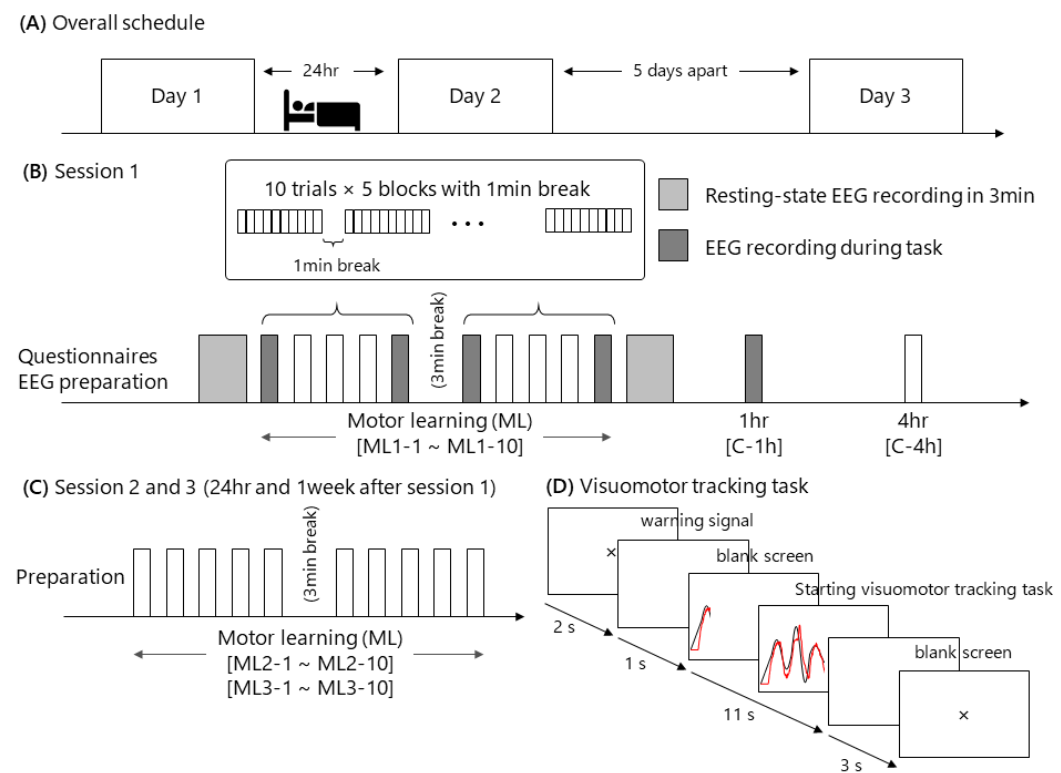
Figure 2. Experimental procedure for motor learning (ML) and overlearning. ( A ) shows the overall schedule of the present experiment. Each participant performed the initial ML on the appointed day (Session 1), followed by overlearning at 24 h (Session 2) and 1 week (Session 3) after the completion of the initial ML. ( B ) presents the experimental procedure during Session 1. After arriving at the laboratory, the participants answered questionnaires about their characteristics, premenstrual syndrome (PMS) and interoceptive awareness, followed by preparation for electroencephalography (EEG) measurements. Next, baseline EEG was recorded in the resting state. Subsequently, the initial ML task, consisting of two sets of 5 blocks with 10 visuomotor tracking task trials in each block (termed ML1-1 to ML1-10), was conducted; EEG recordings were taken during the first, fifth, sixth and tenth blocks (ML1-1, 1-5, 1-6 and 1-10). Resting-state EEG was recorded immediately after the initial ML. Later, one block was performed 1 h after the end of the initial ML with EEG recording, and one block was performed 4 h after the initial ML was completed. ( C , D ) show the experimental procedures during Session 2 and Session 3. The participants performed ML with the same sensorimotor tasks as in the initial ML (as overlearning) without EEG recordings. ( D ) shows a paradigm of the present visuomotor tracking